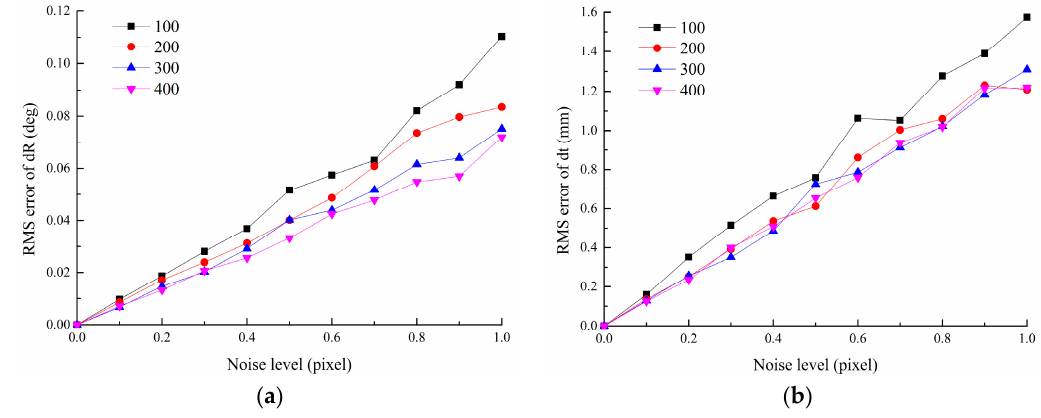
Figure 5. Error vs. the distance of parallel lines: ( a ) RMS error of rotation vs. the distance; ( b ) RMS error of translation vs. the distance.